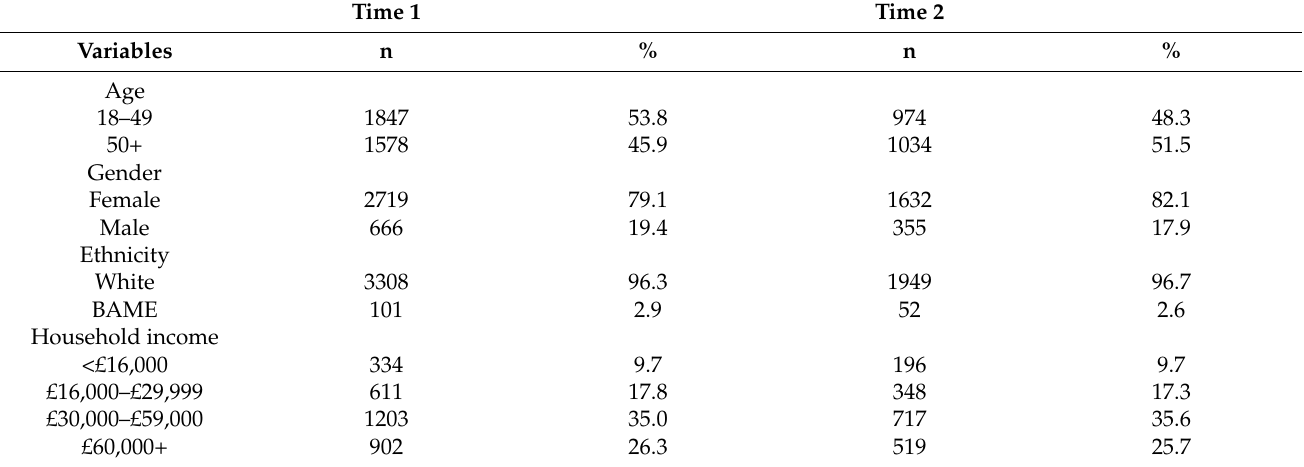
Table 1. Sociodemographic and health variables for the sample at survey one (Time 1) and survey two (Time